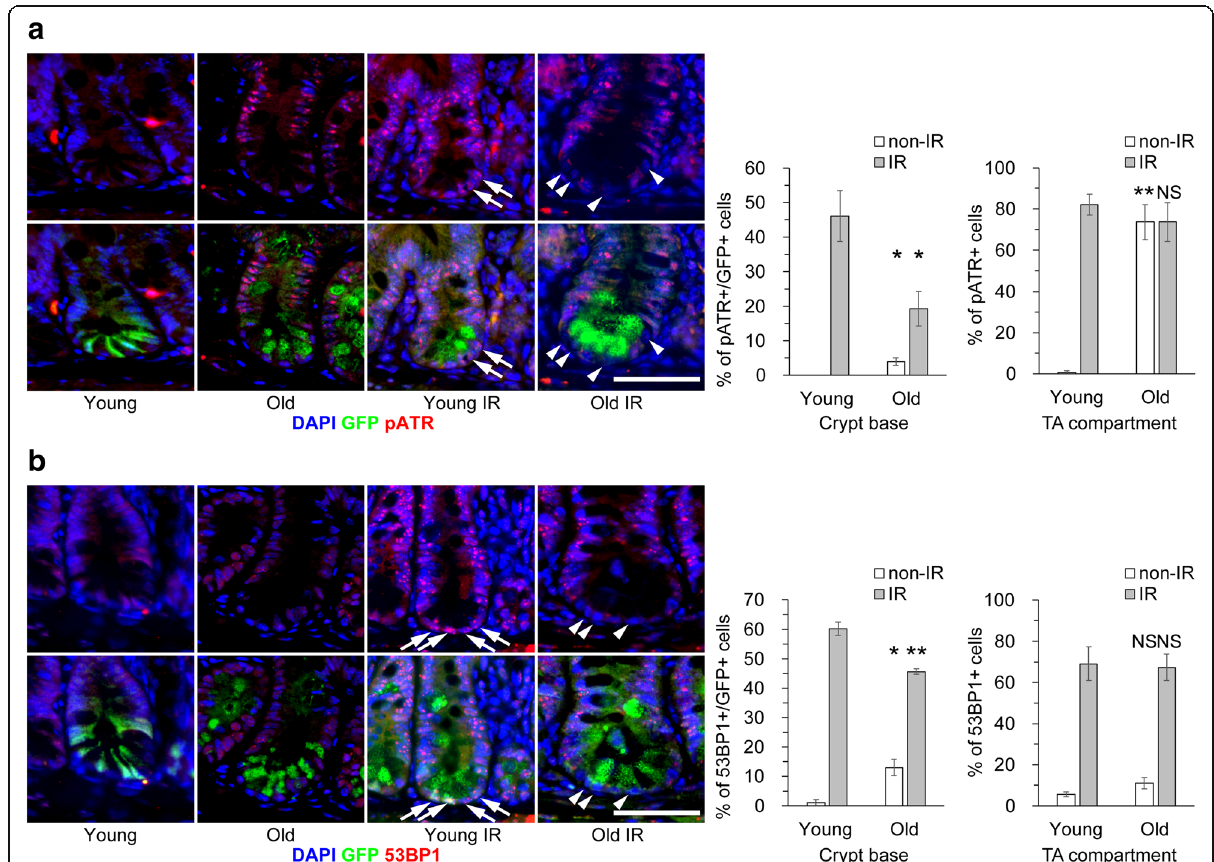
Fig. 1 The DDR is perturbed in old ISCs. Immunohistochemical analyses of DDR marker proteins were performed in young and old jejunum with (IR) or without 10 Gy X-ray irradiation (non-IR). Representative images stained with anti-pATR and anti-53BP1 antibodies, together with graphs of the percentages of positive cells, are shown in a and b , respectively. Arrowheads indicate GFP positive and pATR or 53BP1 negative cells. Data are mean ± s.e.m. ( n = 3 and > 100 GFP+ cells). * p < 0.05, ** p < 0.01, NS > 0.05. Scale bars, 50 μ